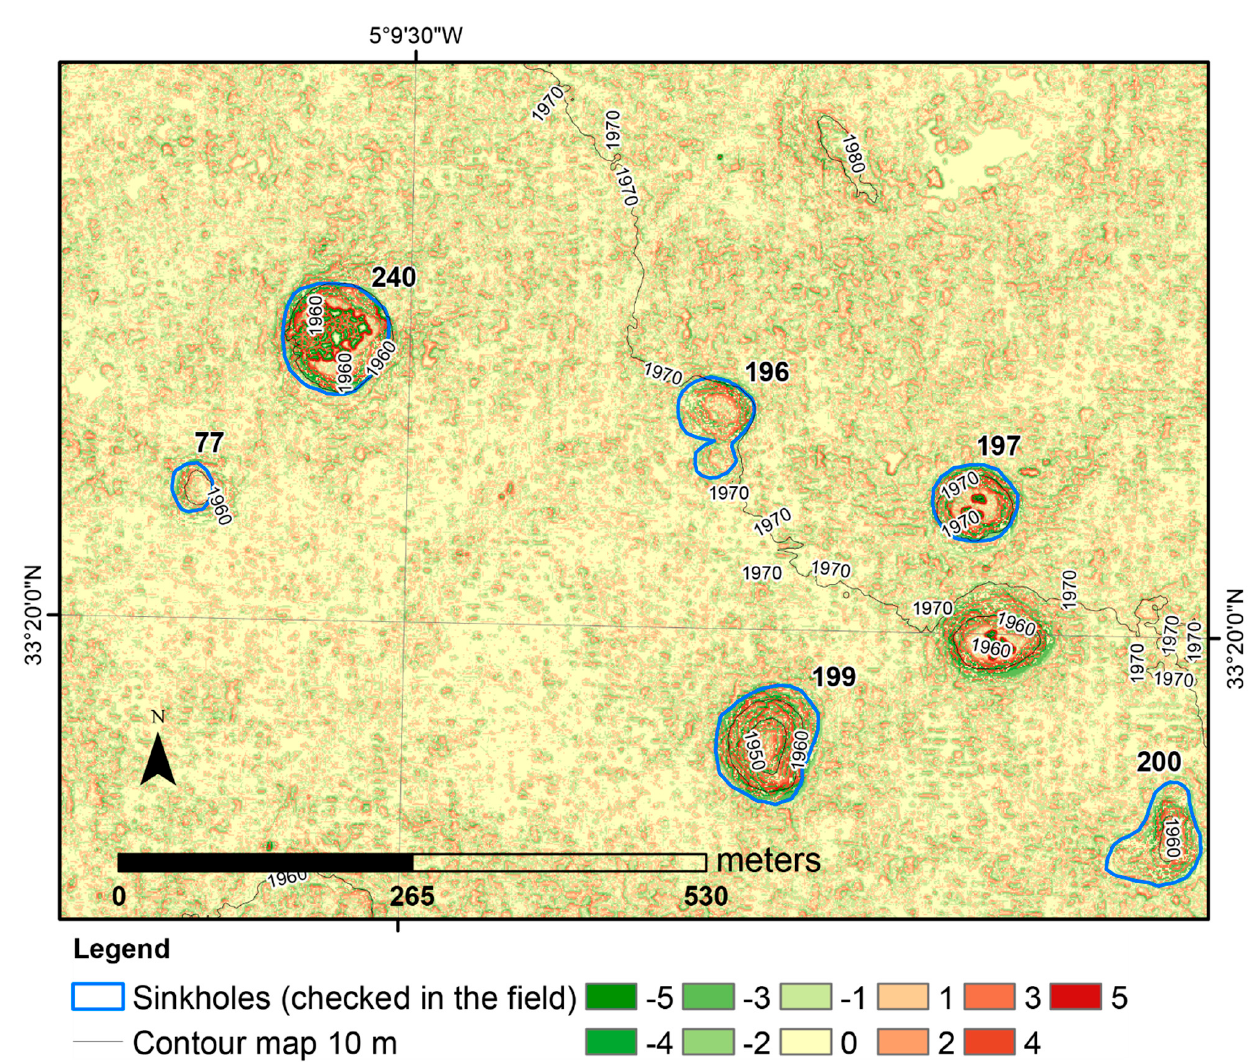
Figure 4. The morphometric map shows the overlay of the sinkholes as mapped in the field on the depressions extracted from the combination of the profile curvature and slope maps. The green color in the legend represents pixels with a negative curvature value ranging from low to high value of slope (from − 5 to − 1); red pixels have a positive value of curvature value, ranging from low to high value of slope (from 1 to 5). The zero value, in bright yellow, represents flat areas. Black bold numbers identify the codes given to name the mapped dolines.